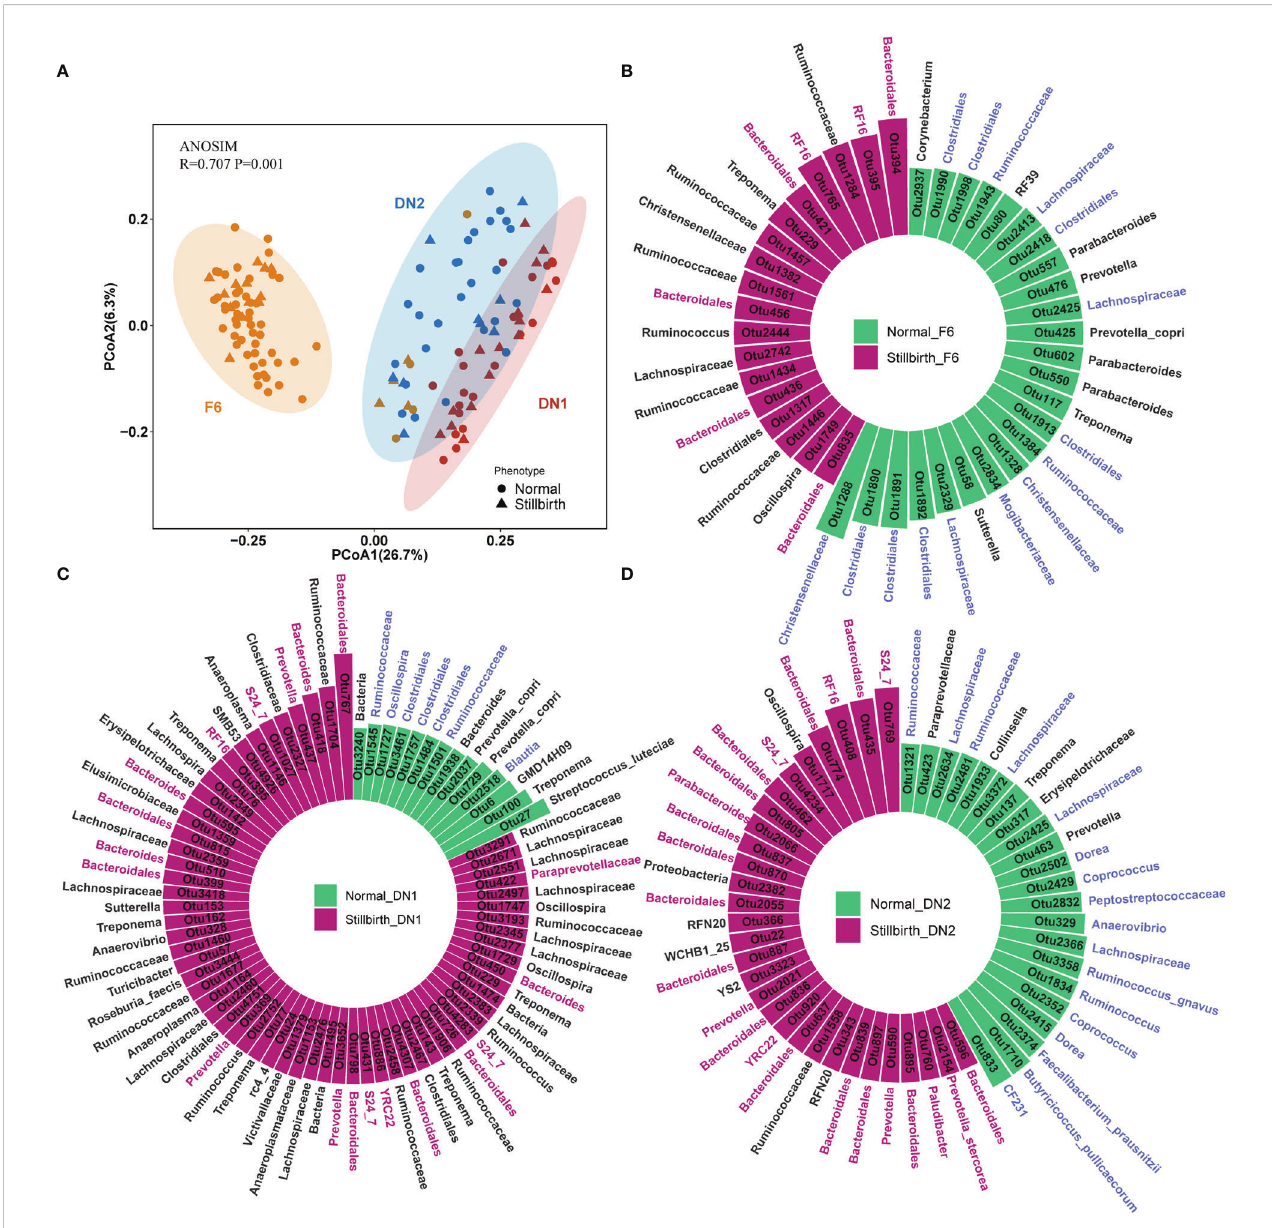
FIGURE 2 Comparison of bacterial compositions and identi fi cation of OTUs associated with sows giving birth to stillborn piglets in three cohorts based on 16S rRNA gene sequencing data. (A) PCoA analysis based on the relative abundance of OTUs. ANOSIM was used to compare the gut microbial composition among three cohorts. (B – D) The OTUs showing signi fi cantly differential abundances between stillbirth and normal sows in the F6 cohort (B) , DN1 cohort (C) and DN2 cohort (D) by LEfSe. The circle histogram showing the OTUs with the LDA score > 2. Blue taxa names represent the OTUs belonging to the order Clostridiales, and red taxa names represent the OTUs belonging to the order Bacteroidales. Green bars indicate the OTUs enriched in the gut of normal sows, and red bars show the OTUs enriched in stillbirth